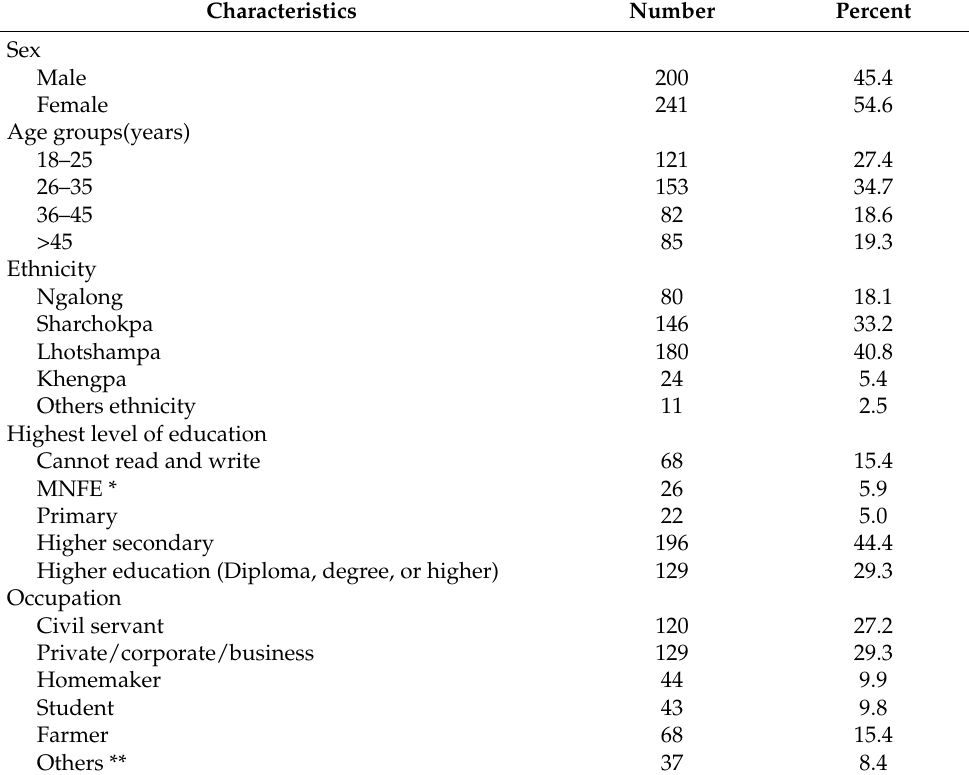
Table 1. Demographic characteristics of the participants in Phuentsholing Hospital, Bhutan.